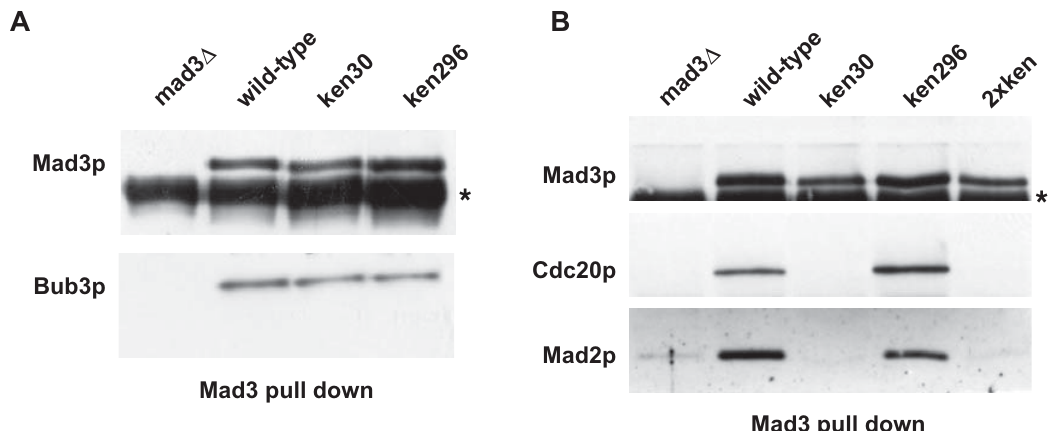
Figure 4. mad3-KEN30AAAfails to form a mitotic checkpoint complex (MCC). A) mad3-KEN-AAA mutants can bind Bub3p. Native extracts were made from the indicated strains, containing Bub3-myc 13 , and Mad3p complexes were immunoprecipitated then immunoblotted for Mad3p and Bub3p (anti-myc). B) mad3-KEN30AAA mutants don’t bind to Mad2p or Cdc20p. Cells were arrested in mitosis (with hydroxyurea and nocodazole) and native extracts were made from the indicated strains, containing Cdc20p-myc 13 . Mad3p was immunoprecipitated then immunoblotted for Mad3p, Mad2p and Cdc20p (anti-myc).